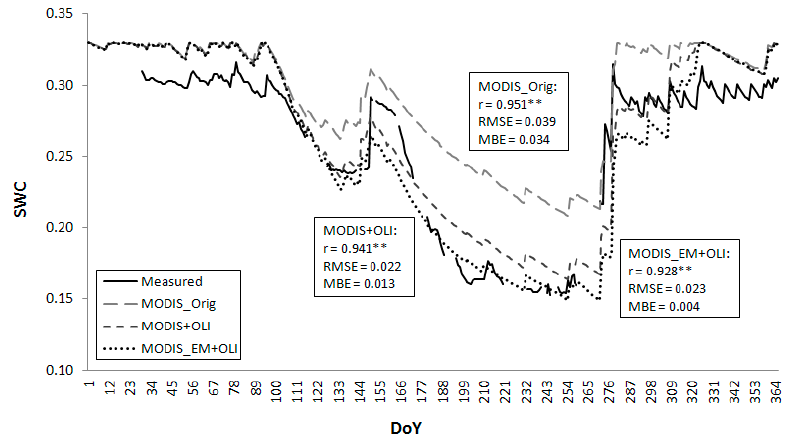
Figure 7. Daily fractional SWC (dimensionless) measured at 30 cm depth and estimated by driving Equation (3) with the different NDVI values considered (see text for details) (** = highly significant correlation, p < 0.01).